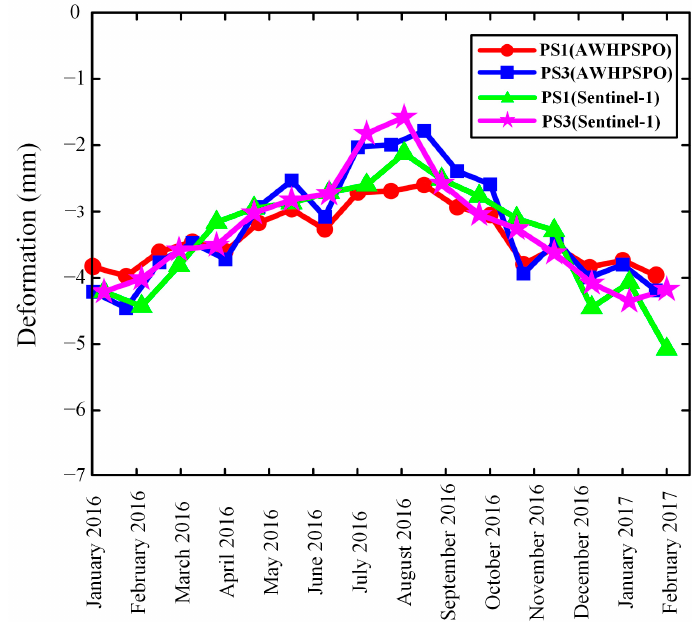
Figure 14. Comparison of AWHPSPO and SBAS-InSAR results.